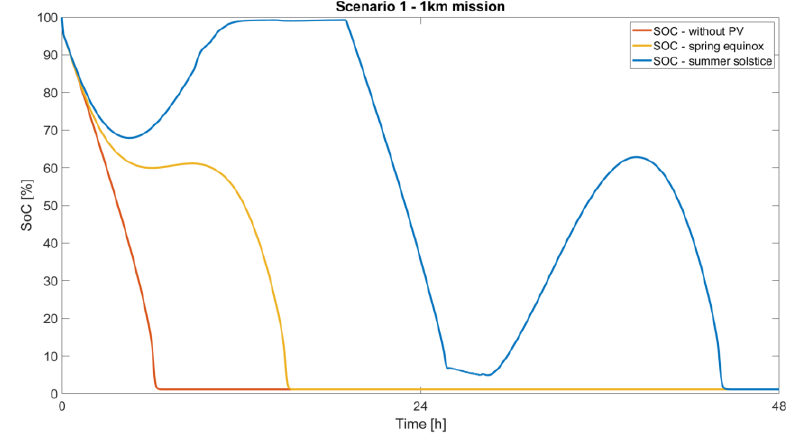
Figure 10. State of charge of the battery during the continuous flight at 1 km.